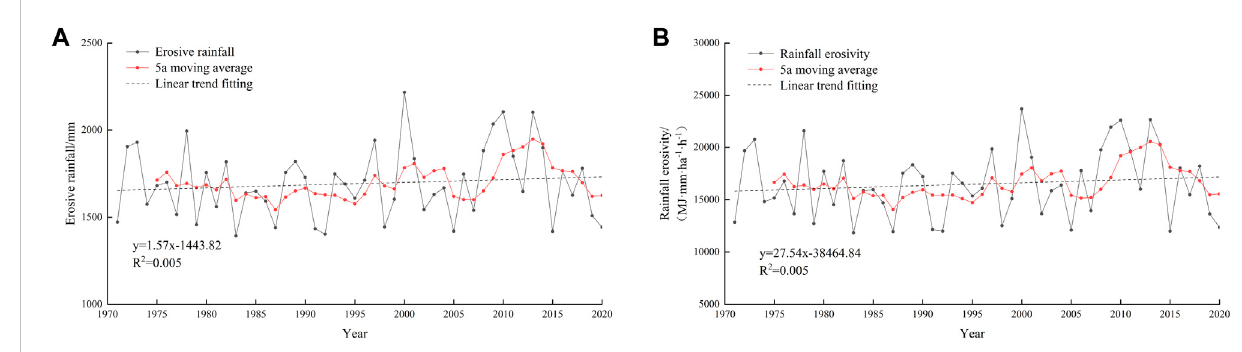
FIGURE 2 Interannual variation in erosive rainfall and rainfall erosivity in the Nandu River Basin.